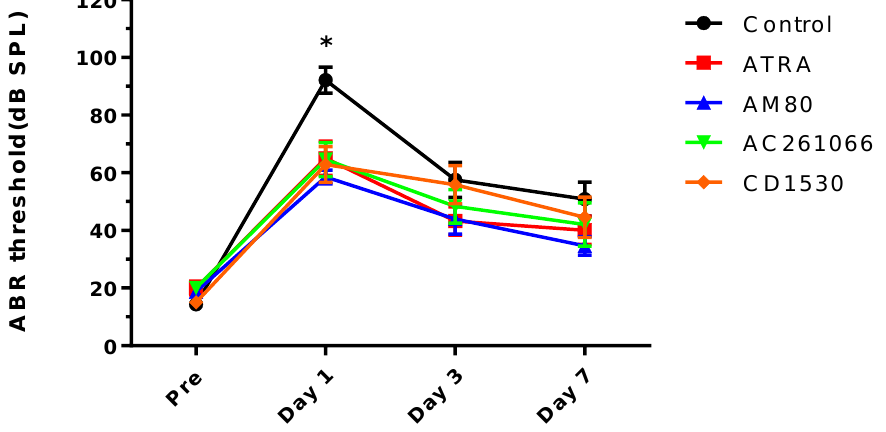
Figure 1. Changes in click-evoked auditory brainstem response (ABR) threshold. Pre indicates before noise exposure, Day 1 is immediately after noise exposure. There was a significant difference among the groups immediately after noise exposure. * p < 0.05.